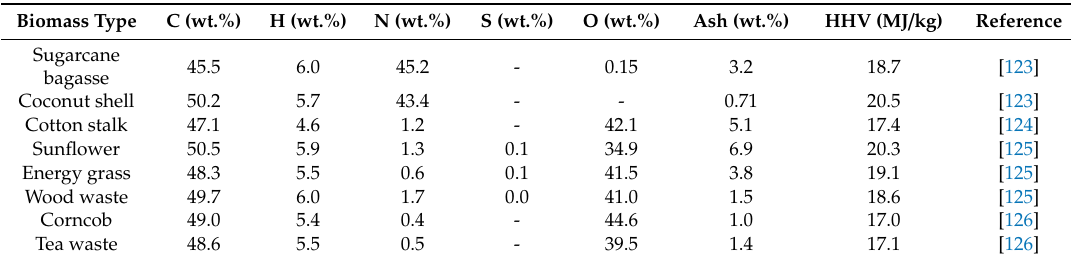
Table 5. Elemental compositions (N, O, S, H, C) di ff erent types of biomass. Biomass